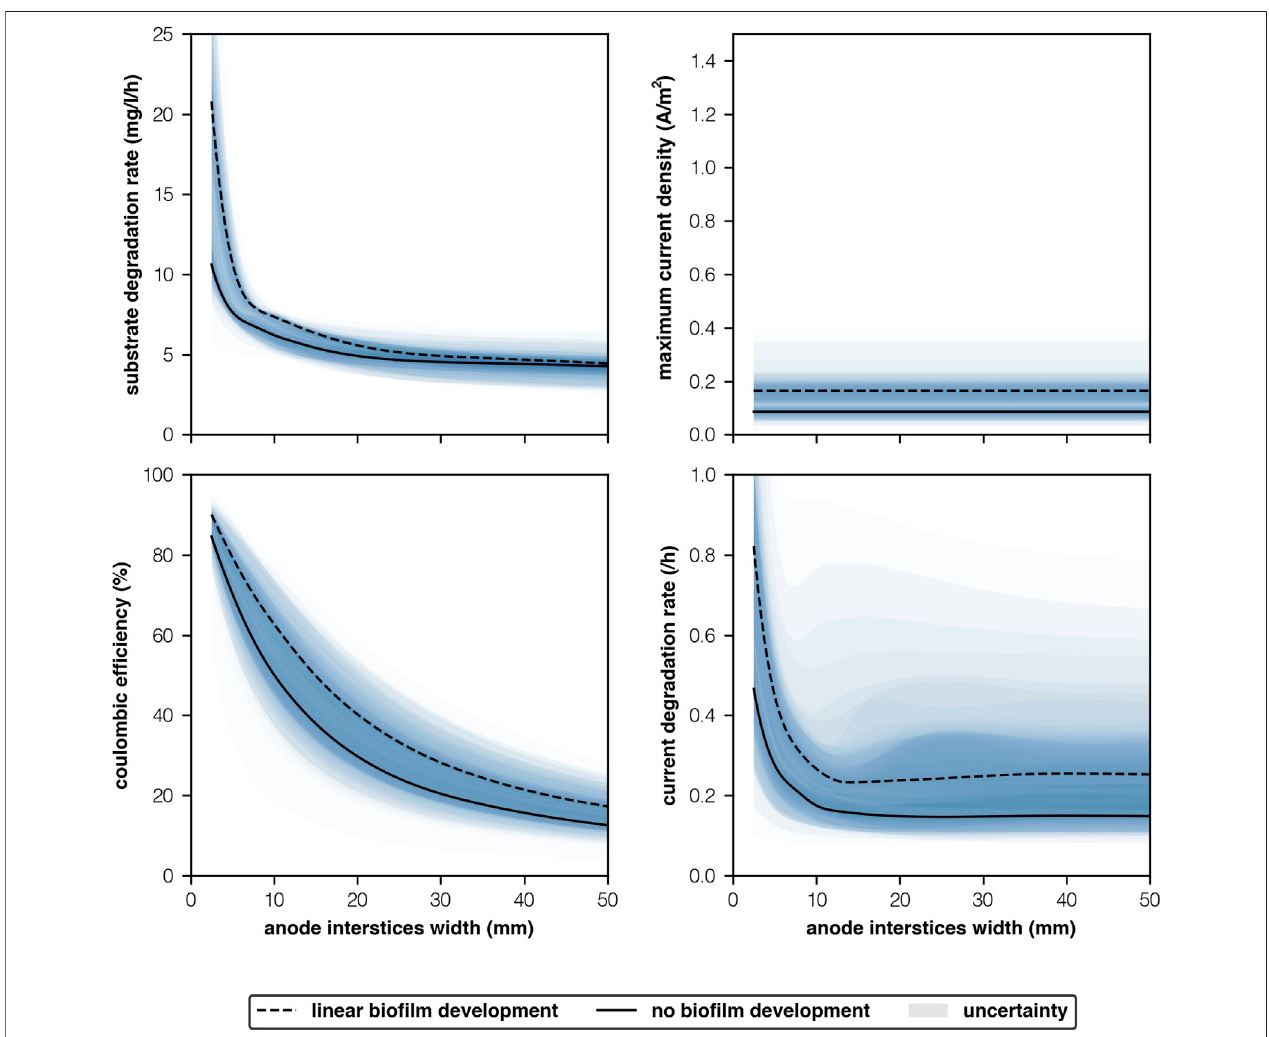
FIGURE 4 | Model predictions with respect to anode interstices ’ width (mm) at 50 mg-COD/l.